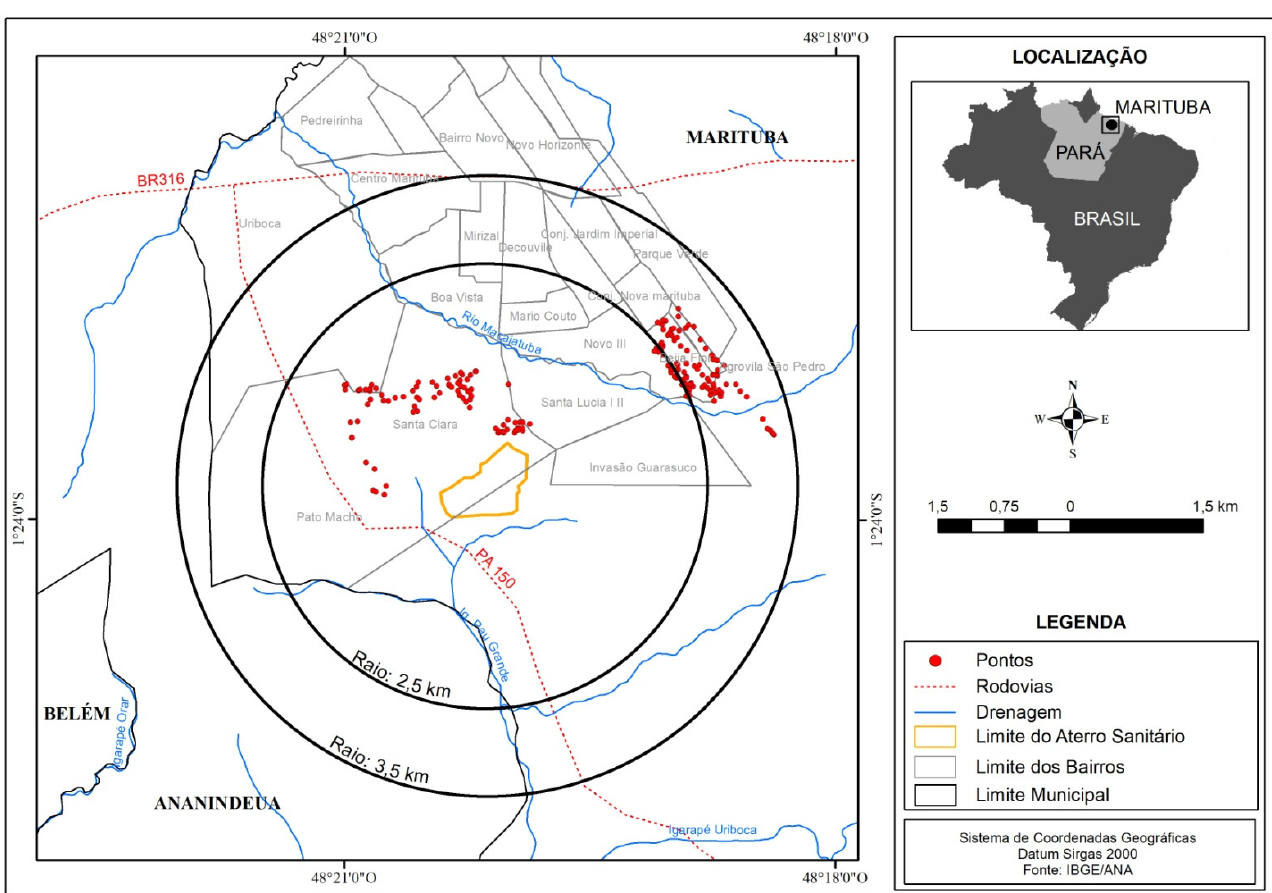
Figure 1. Location map of the points collected around the landfill in the municipality of Marituba, Pará State, Brazil.